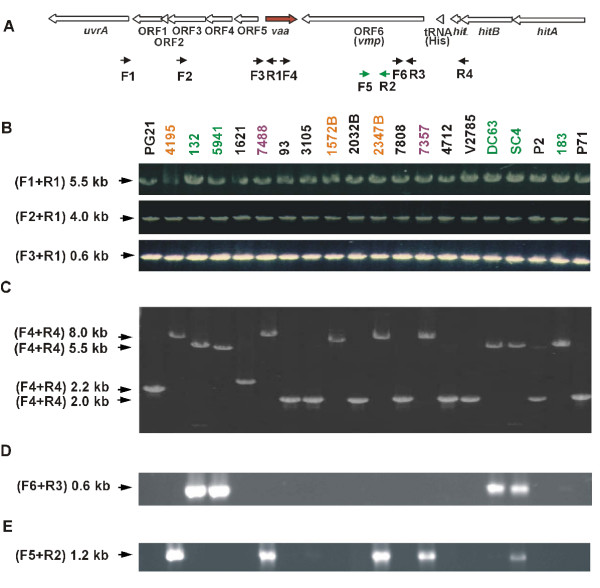
Up- and downstream PCR analysis of 20 M. hominis isolates and vmp PCR. A, Top: Schematic illustration of the open reading frames (indicated by open arrows) of the vaa locus of M. hominis isolate 132. Bottom: The position relative to the open reading frames of the primers used (indicated by small arrows). B, Agarose gel electrophoresis of the PCR reactions obtained using vaa upstream primer sets (F1, R1), (F2, R1) and (F3, R1) on the 20 M. hominis isolates indicated above the bands. The size of the PCR products and primer set used are indicated to the left. C, D and E, PCR reactions observed using the vaa downstream primer sets (F4, R4), (F6, R3) and (F5, R2), respectively. The (F6, R3) primer set was derived from vmp-1 and the (F5, R2) primer set (green arrows) was derived from the vmp-2 and vmp-3 genes of isolates 4195 and 7488. Isolates categorized as having vmp-1, vmp-2 and vmp-3 genes are indicated with green, orange and magenta coloring of letters, respectively.